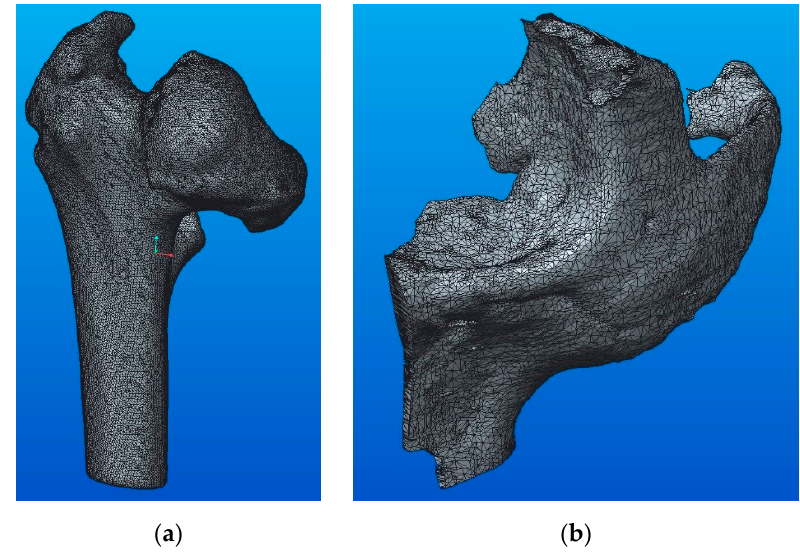
Figure 1. Three-dimensional (3D) models: ( a ) femoral bone; ( b ) zygomatic bone.